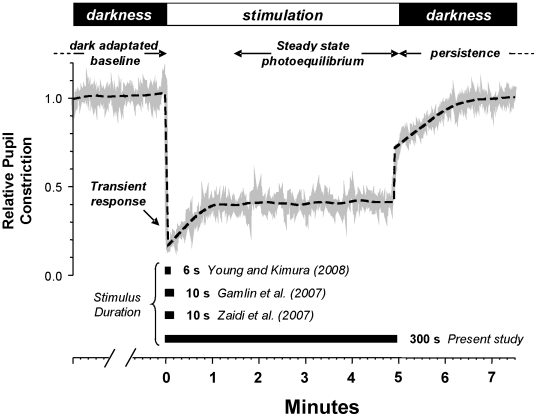
The pupillary light reflex response is composed of several different temporal components.In a totally dark-adapted (40 min) subject, the consensual pupil response was measured in one eye while illuminating the entire visual field of the opposite eye (1e13 photons/cm2/sec at 480 nm). At stimulus onset the pupil rapidly constricts to a minimal size referred to as the transient response that lasts 500–1000 ms [15], [24]. This is followed by a redilation to a tonic or sustained pupil size, previously described for durations <10 sec (bars in bottom of figure; [15], [29], [37]). By maintaining a prolonged constant illumination of the retina, pupil size stabilizes to a true steady state “photoequilibrium”. The time required to attain this photoequilibrium depends on the irradiance and wavelength of the stimulus. In the case shown the pupil reaches stable constriction in roughly 1 minute and maintains that constriction level until extinction of the stimulus. At light offset, the pupil slowly recovers to the dilated dark adapted state (post-stimulus persistence). The solid gray line shows the raw pupil constriction recordings and the dashed line the smoothed response function (further details in Methods).